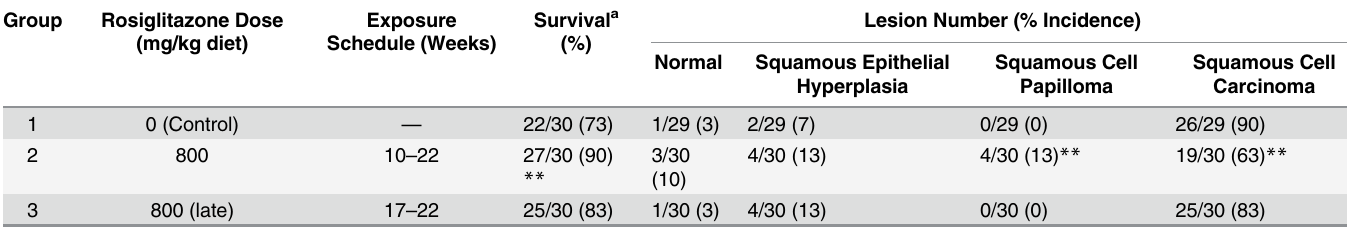
Table 2. Influence of Rosiglitazone on Survival and Incidence of Preneoplastic and Neoplastic Oral Lesions in NQO-Treated F344 Rats. Group Rosiglitazone Dose (mg/kg diet)